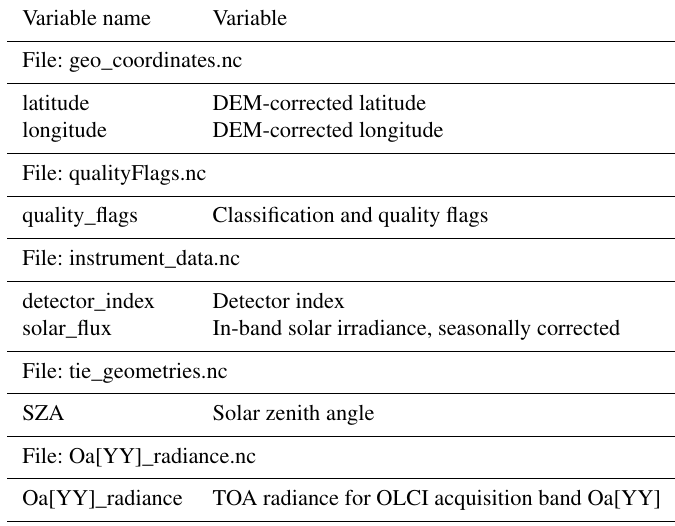
Table A2. Sentinel-3 OL_1_ERR files and variables used. Here, [YY] denotes OLCI band numbers 1–21. Variable